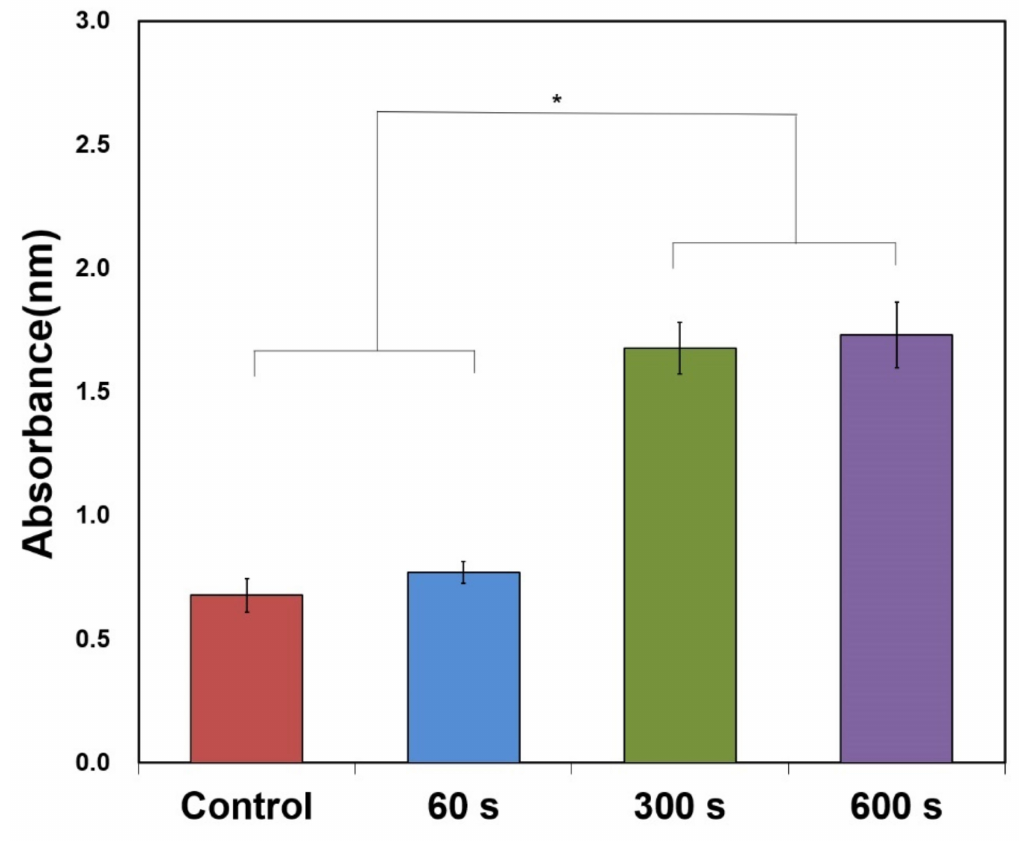
Figure 6. Crystal violet assay after plasma treatment. *: Significant difference at p <